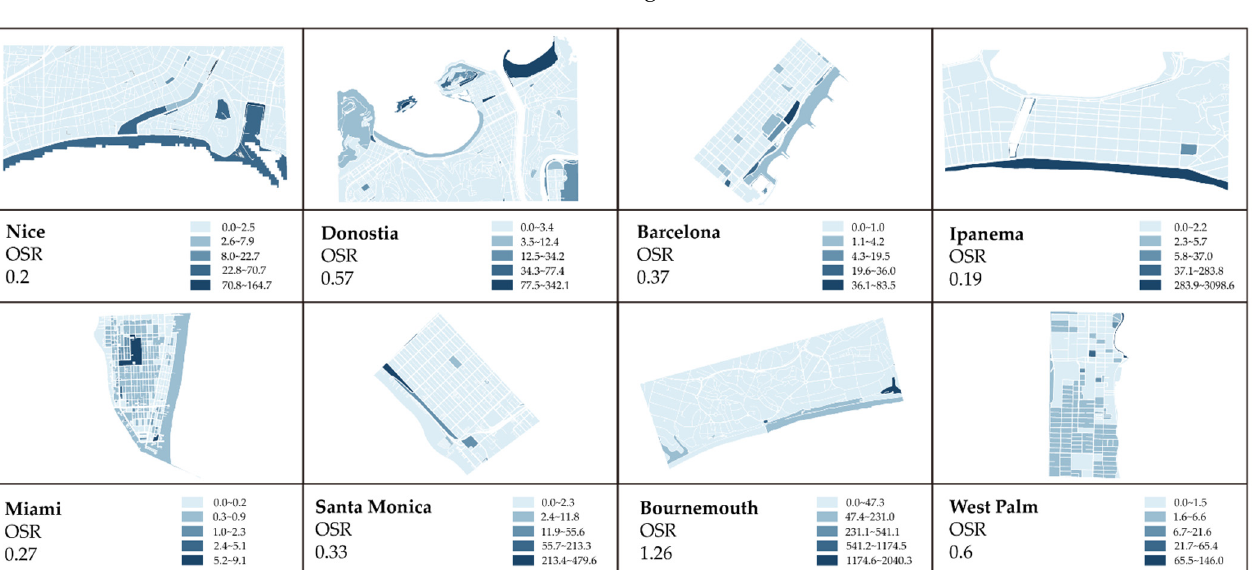
Figure 13. The distribution of average floors in successful coastal cases.